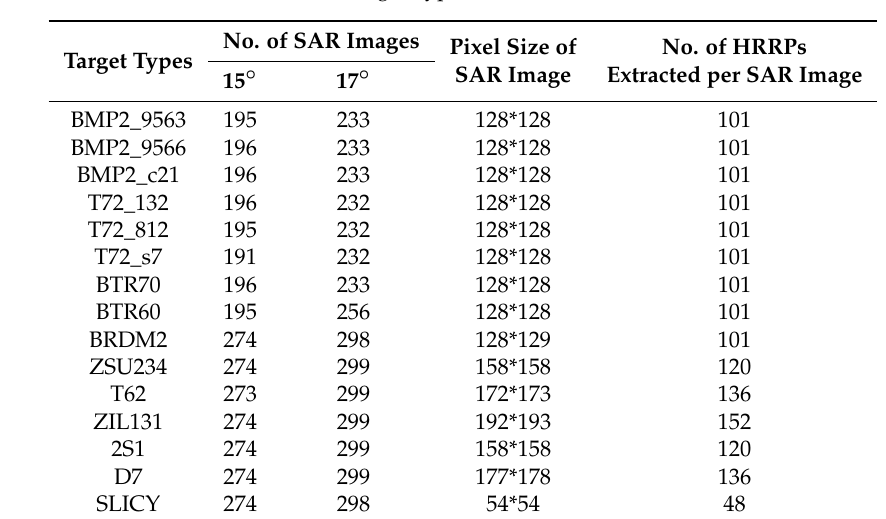
Figure 6. Images of the MSTAR targets. Table 1. Target Types in MSTAR